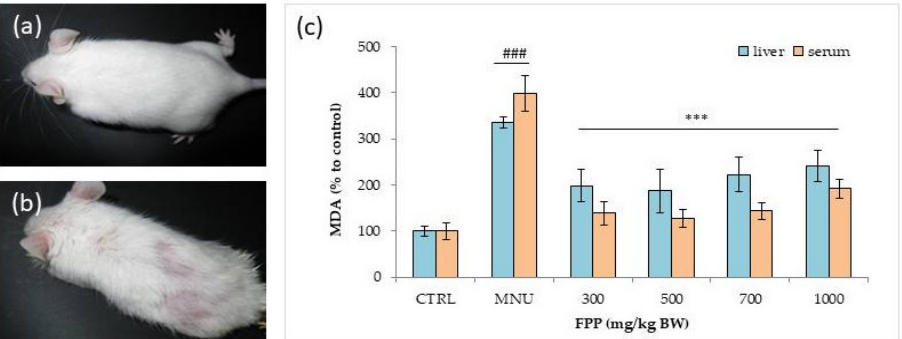
Figure 4. ( a ) Physical appearance of balb/c mice from the PBS control group and ( b ) N -methyl- N -nitrosourea (MNU) control group. ( c ) Malondialdehyde (MDA) levels in fermented papaya preparation (FPP)-supplemented balb/c mice treated with or without MNU. Data is presented as the mean of five replicates, where error bars represent ± standard deviation. ### p < 0.001 vs. PBS control; *** p < 0.001 vs. MNU control. Reproduced with permission from Somanah et al. [71], Life Sciences; published by Elsevier, 2016.